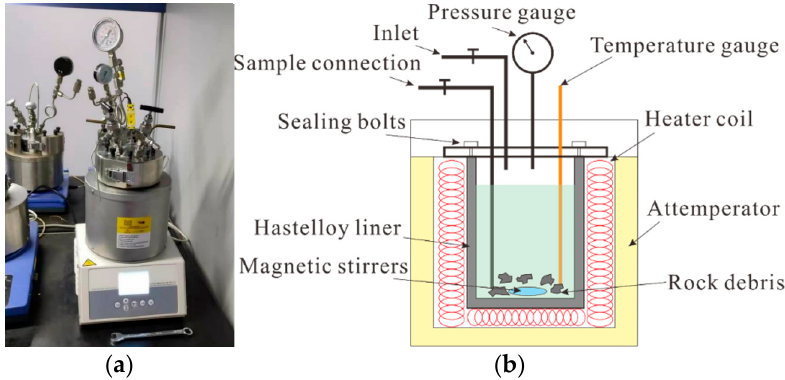
Figure 4. ( a ) Equipment and ( b ) structure of the reactor.